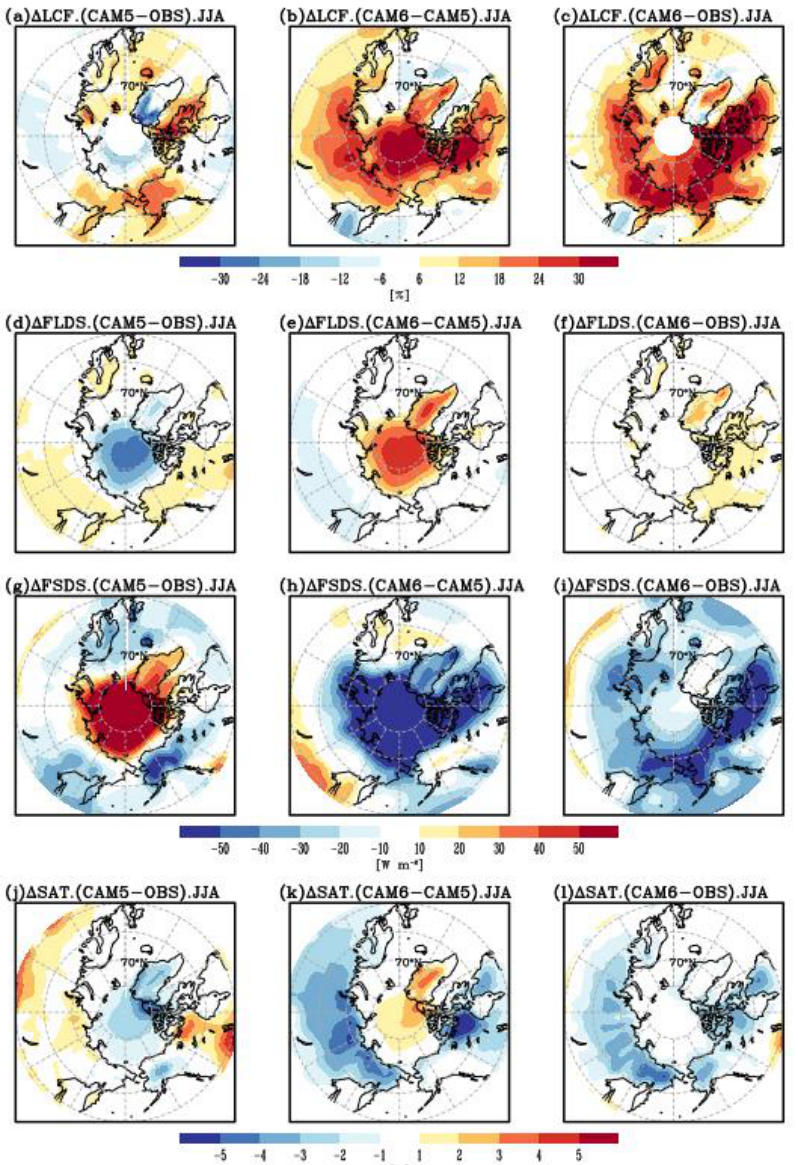
Figure 6. Biases of ( a – c ) low cloud fraction (LCF) against the CALIPSO – GOCCP observation, ( d – f ) downward longwave (LW) radiative flux at the surface (FLDS), ( g – i ) downward shortwave (SW) radiative flux at the surface (FSDS), and ( j – l ) surface air temperature (SAT) against the ERA-Interim reanalysis during JJA obtained from ( left ) CAM5 and ( right ) CAM6, and ( center ) the differences in each variable between CAM6 and CAM5.